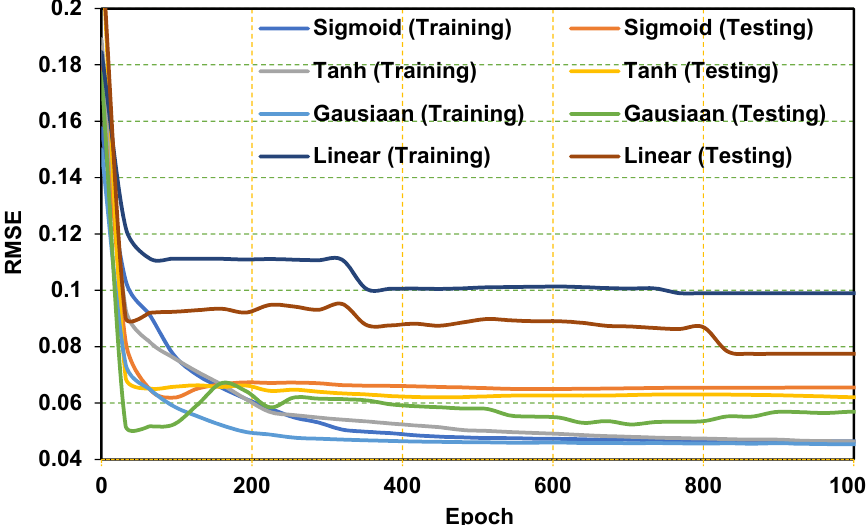
Figure 3. Convergence of RMSE after 1000 epochs having six neurons in the hidden layer.